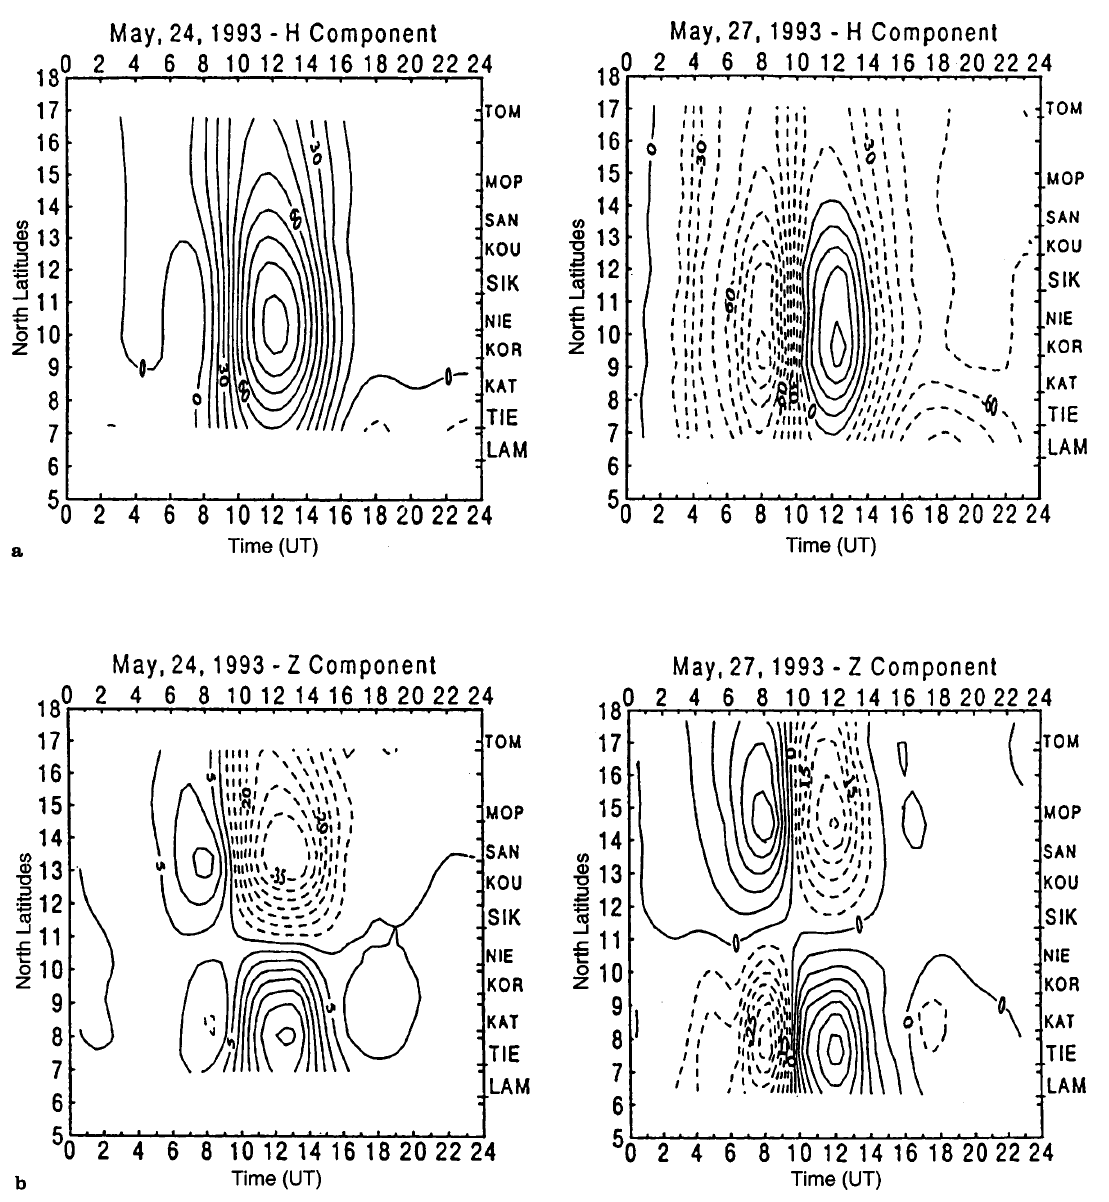
inversion of the jet circulation is indicated by the negative sign ( dashed line ) in the H -component, whereas the positive sign in the northern hemisphere (above SIK) of Z plot attests to this